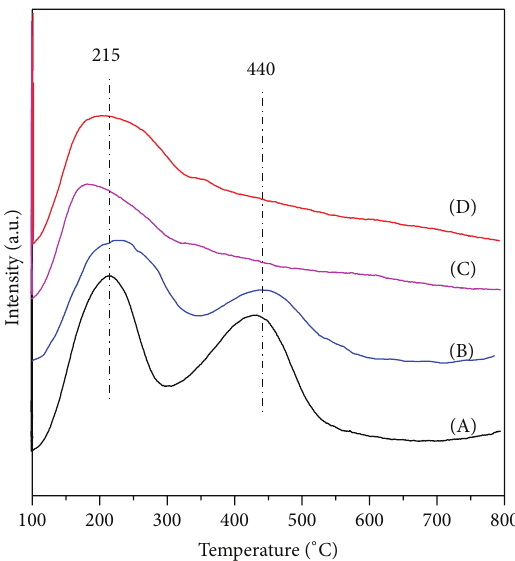
Figure 2: NH 3 -TPD results of (A) H-ZSM-5, (B) 0.5 Zn/ZSM-5, (C)